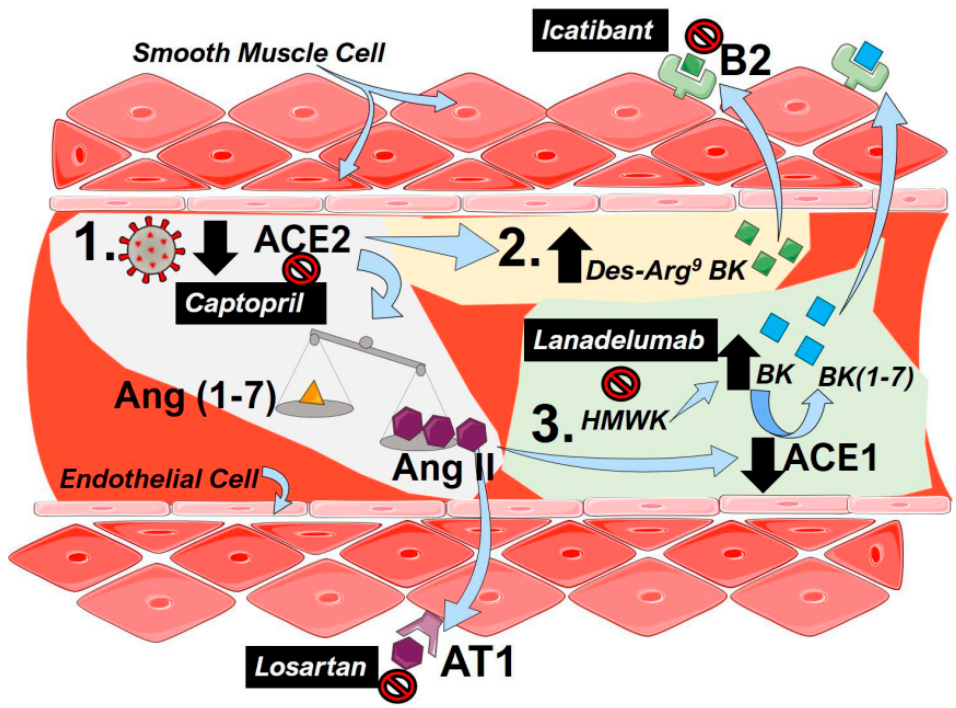
Figure 1. The renin–angiotensin system (RAS) including bradykinin in coronavirus disease 2019 (COVID-19). (1) To infect cells, severe acute respiratory syndrome coronavirus 2 (SARS-CoV-2) binds to angiotensin converting enzyme 2 (ACE2), resulting in a functional loss of enzyme due to internalization and reduced expression of ACE2. This results in an imbalance of the angiotensin (Ang, 1–7, yellow triangles) and Ang (II, purple hexagons), favoring the accumulation of Ang II. Then, Ang II is able to bind to angiotensin receptor 1 (AT1) to mediate pulmonary vasoconstriction and inflammation. (2) Depletion of ACE2 activity following SARS-CoV-2 infection results in an increased a Des-Arg9-Bradykinin (BK, green squares) that can activate the bradykinin (B)2 receptor to promote vasoconstriction. (3) High-molecular-weight-kallikrein (HMWK) is converted to bradykinin (BK, blue squares) that in turn is metabolized to BL (1–7) and other metabolites by ACE1. Increased levels of AngII in COVID-19 reduce the enzymatic capacity of ACE1 resulting in an accumulation of BK that can also activate B2 receptors to promote pulmonary vasoconstriction. Clinically tested agents are shown in black boxes with white font. Captopril can inhibit the e ff ect of ACE2, resulting in lower functional receptors for SARS-Cov-2. Losartan, an angiotensin receptor blocker (ARB), antagonizes the AT1 receptor inhibiting the e ff ects of Ang II. Lanadelumab is a monoclonal antibody against HMWK, preventing its cleavage into BK. Icatibant is a B2 antagonist blocking the e ff ects of both